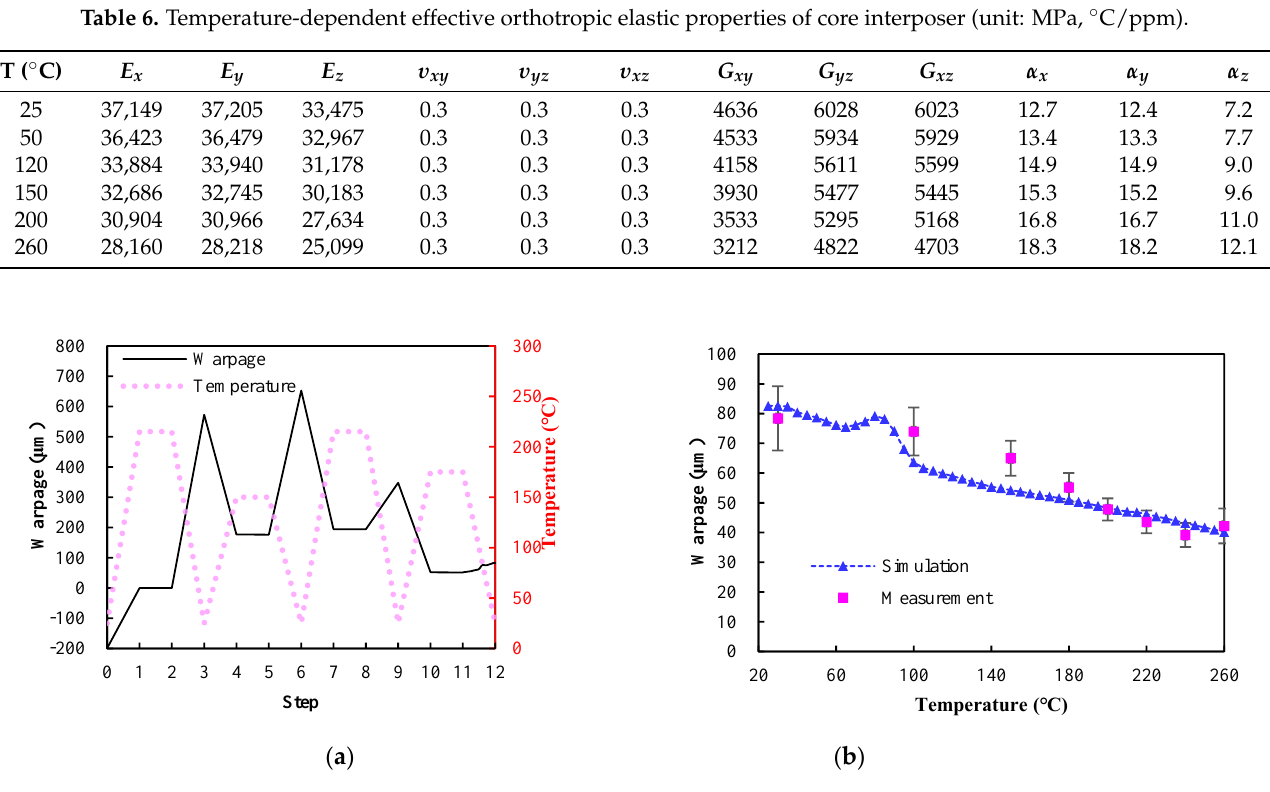
Figure 13. Comparison of simulated and experimental warpages after the mold cure process; ( a ) simulation; ( b ) experiment. Table 7. Warpage comparison between the simulation and measurement.